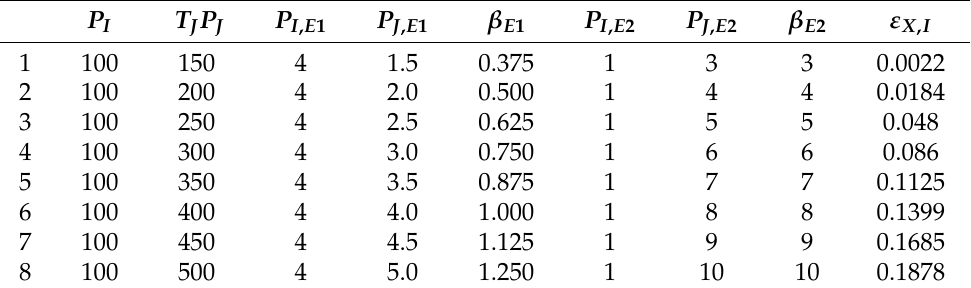
Table 1. The received signal power of X J and X I at E1 and E2, β E 1 and β E 2 for the given transmit power, and ε X , J (is considered at 12 dBm SNR) from Figure 2.